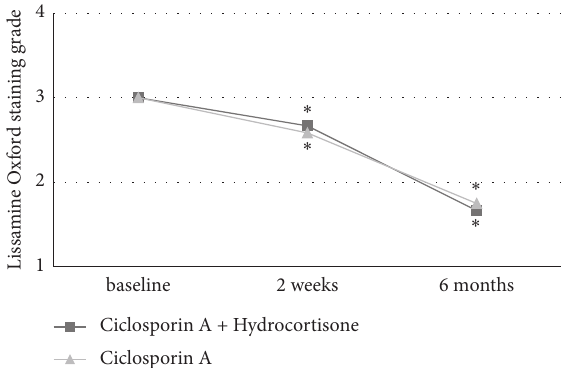
Figure 4: Lissamine Oxford staining grade in both treatment groups at baseline, after 2 weeks, and after 6 months of treatment. Significant differences to baseline are marked with ∗ .